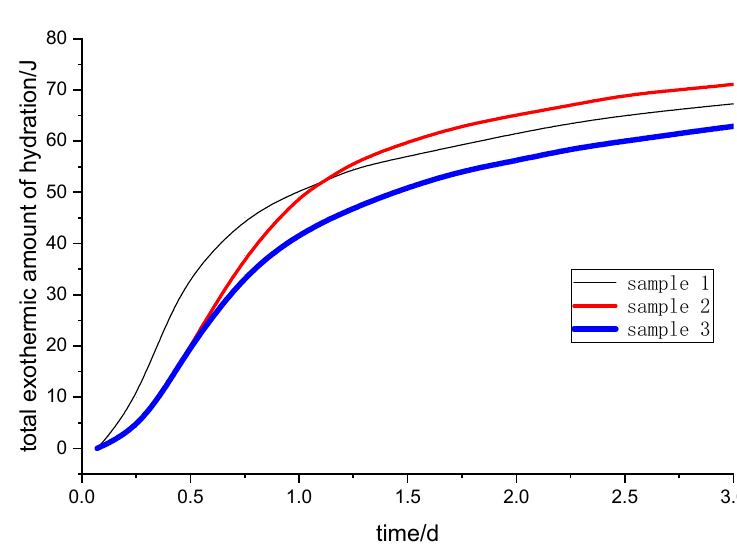
Figure 1. Hydration exothermic curve of different samples.